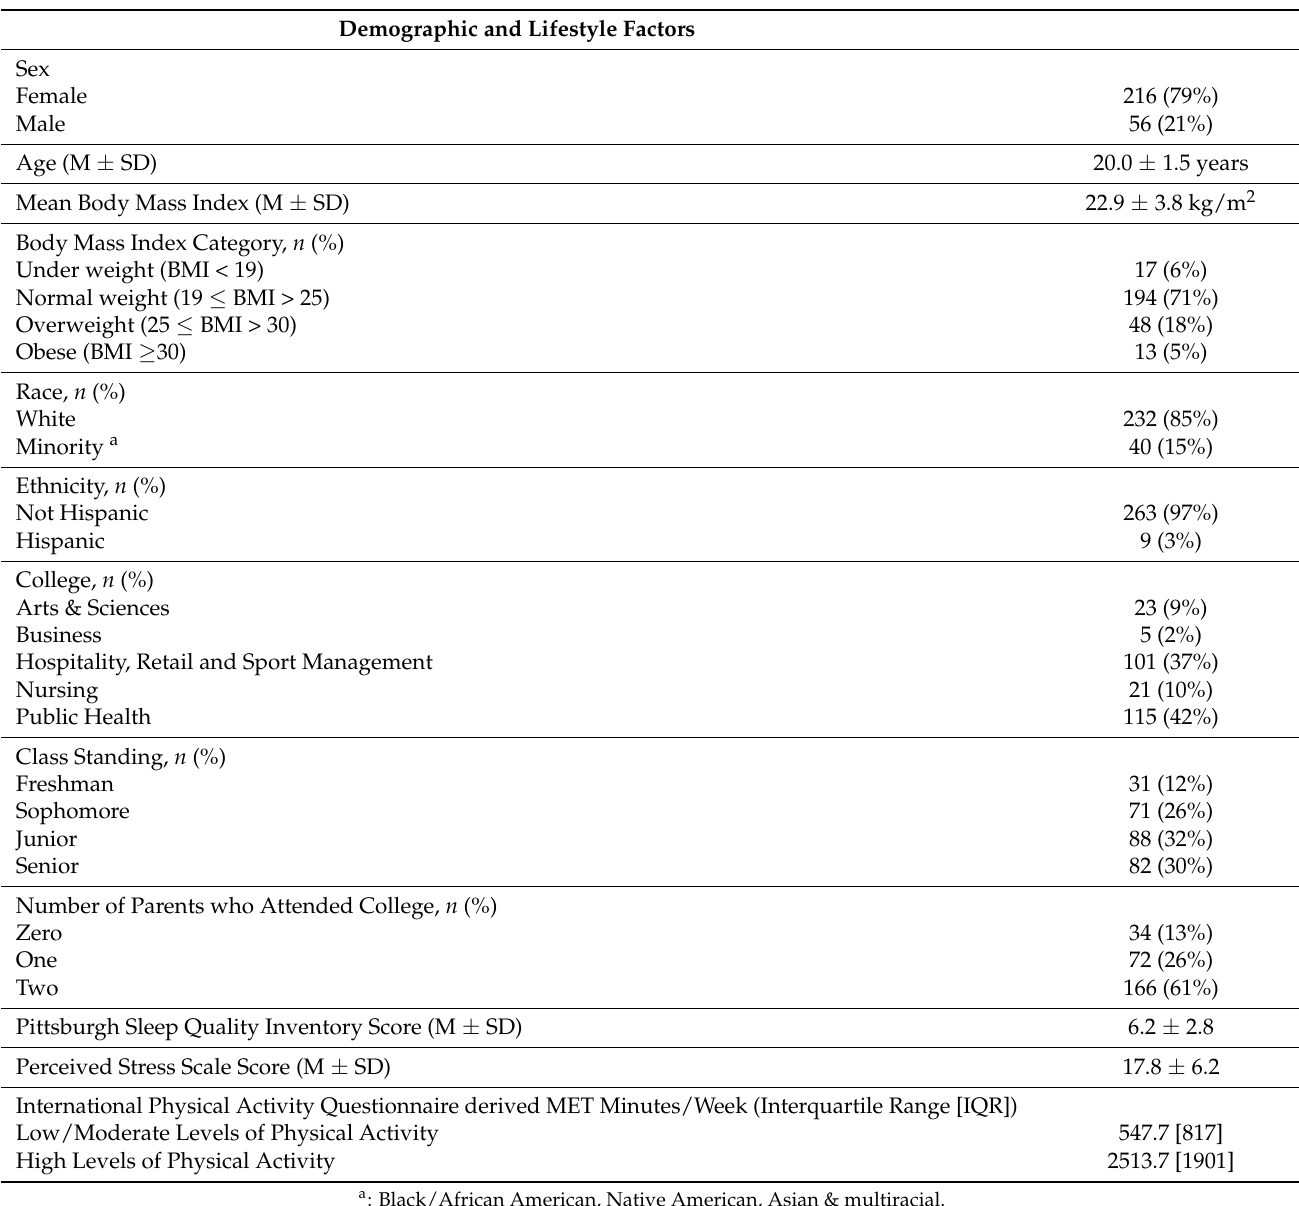
Table 1. Sample ( n = 272)